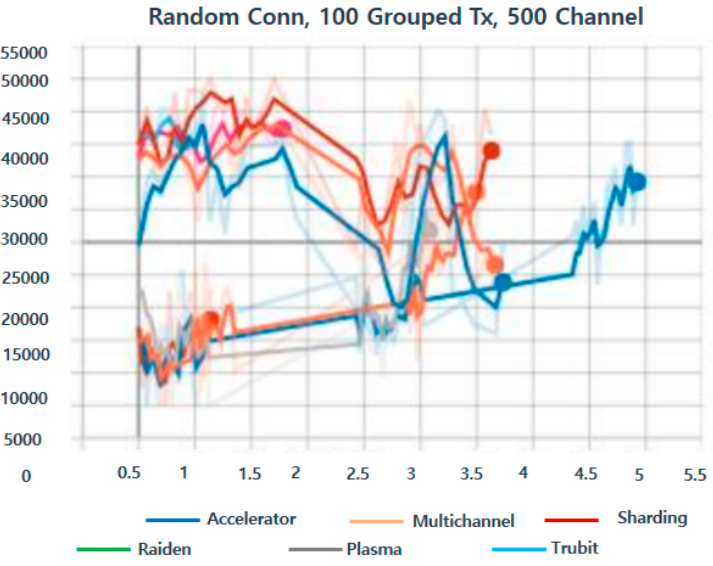
Figure 10. 100 Grouped Tx, 500 Channel.